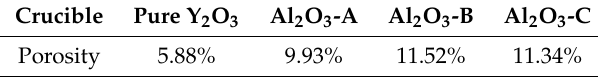
Table 2. The porosity of crucibles. Figure 2. T he XRD spectrum of composite crucibles before the melting experiment. ( a ) The pure Y 2 O 3